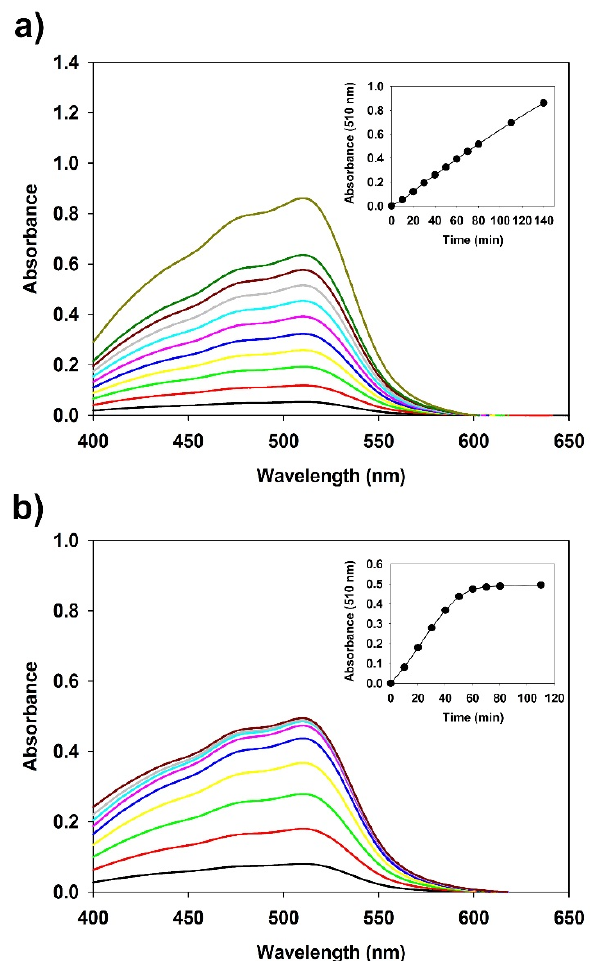
Figure 7. Changes in the absorbance spectra of Fe 2+ -phen complex in Fe 3+ -SG hydrogel beads. Beads with ascorbic acid ( a ) and beads with lactic acid under 405 nm visible light ( b ). Inset: Correlation of absorbance at 510 nm against time.